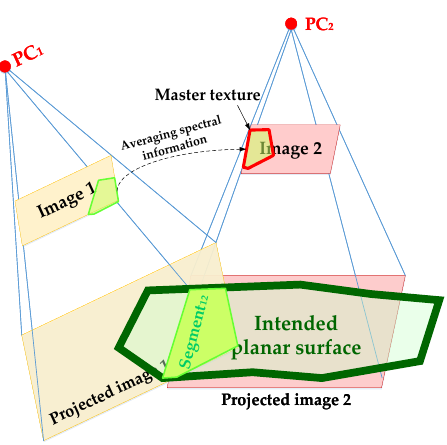
Figure 16. Rendering a segment visible in two images (segment 12 ).